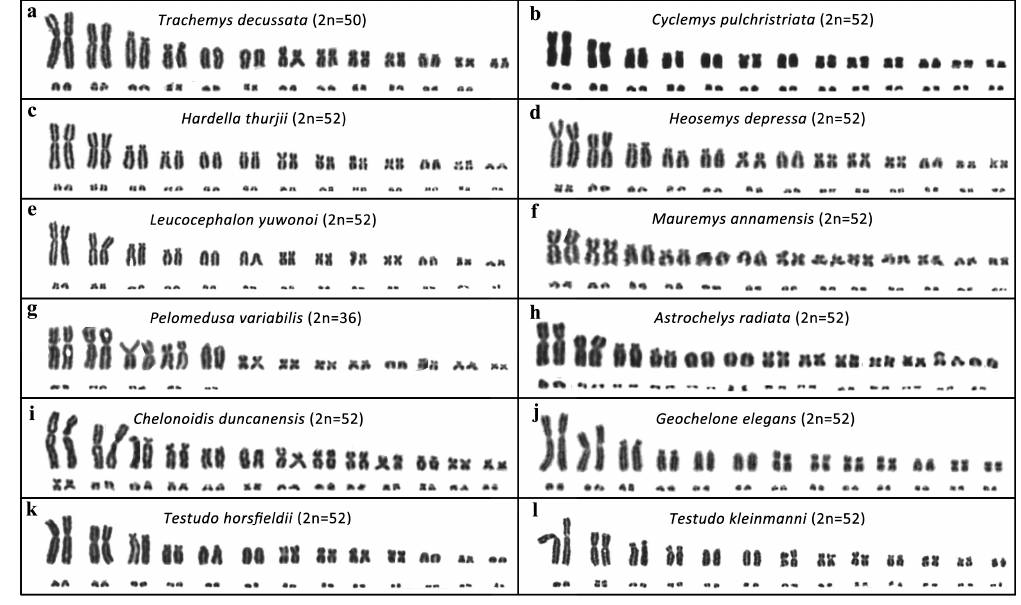
Figure 2. Karyograms of ( a ) Trachemys decussata (Emydidae), ( b ) Cyclemys pulchristriata , ( c ) Hardella thurjii , ( d ) Heosemys depressa , ( e ) Leucocephalon yuwonoi , ( f ) Mauremys annamensis (all Geoemydidae), ( g ) Pelomedusa variabilis (Pelomedusidae), ( h ) Astrochelys radiata , ( i ) Chelonoidis duncanensis , ( j ) Geochelone elegans , ( k ) Testudo horsfieldii , ( l ) Testudo kleinmanni (all Testudinidae).